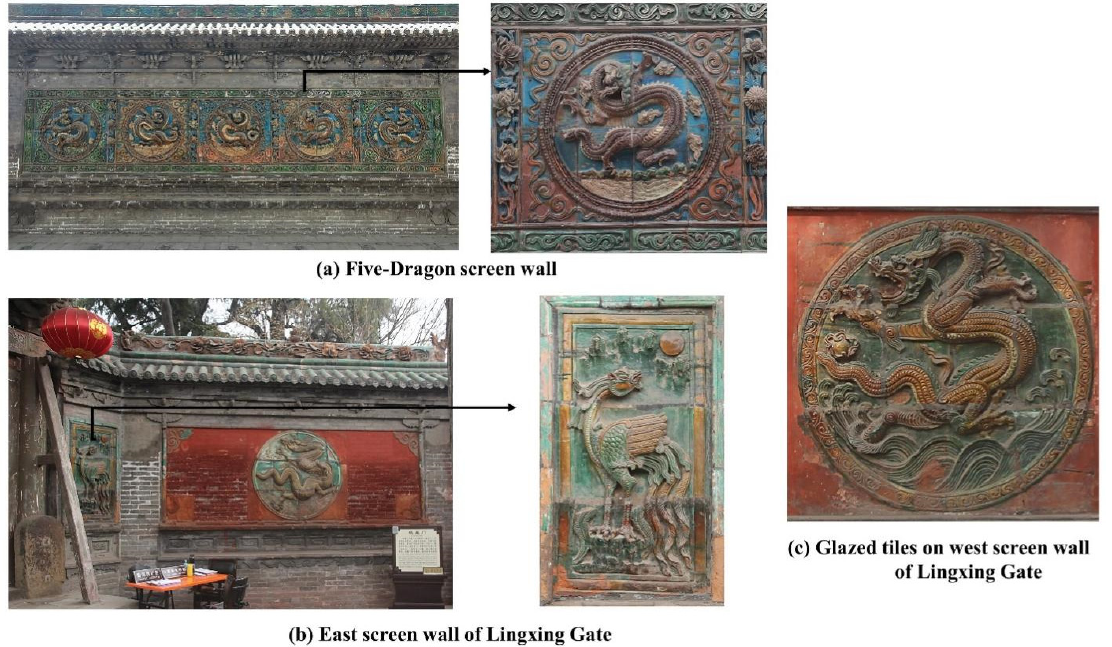
Figure 3. Screen walls with glazed tile decoration in the Hancheng Confucian Temple building complex.